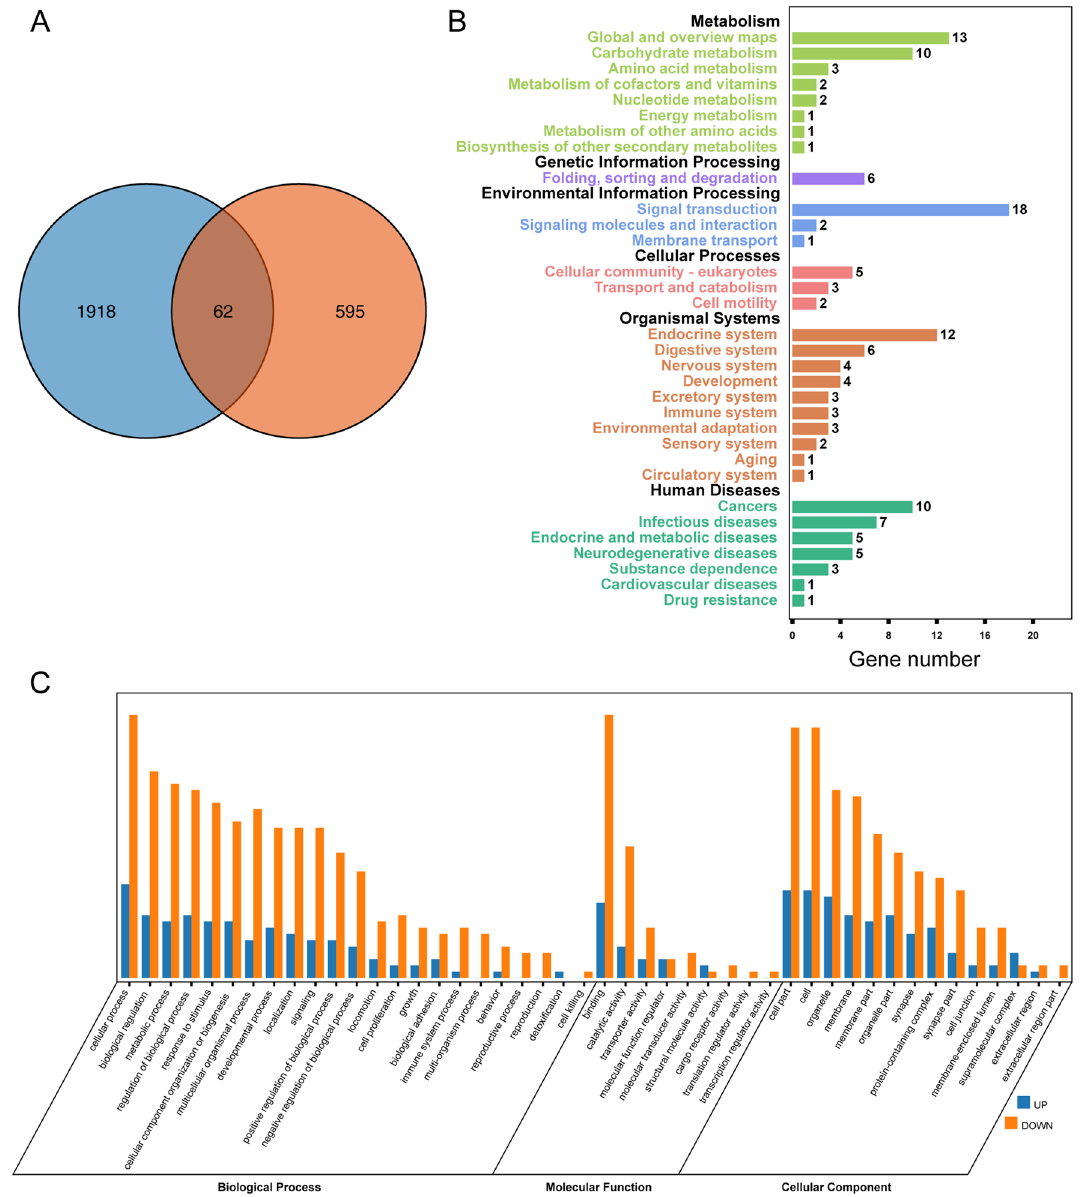
Figure 2. Comparison of early brain protein expression profiles with mice. ( A ) Compared with the brain protein expression profiles of mice from the 9-day postnatal experiment from the Gonzalez-Lozano study (blue), it was found that expression of a total of 62 genes appeared in the differential gene results of Pur ɑ -KO (Orange). These 62 genes may be key regulators of Pur ɑ in early brain development. ( B ) Histogram results of KEGG enrichment analysis of differential genes. The abscissa is the number of genes and the ordinate is the enrichment item. ( C ) GO enrichment of differential genes. Orange indicates genes that are up-regulated and blue indicates